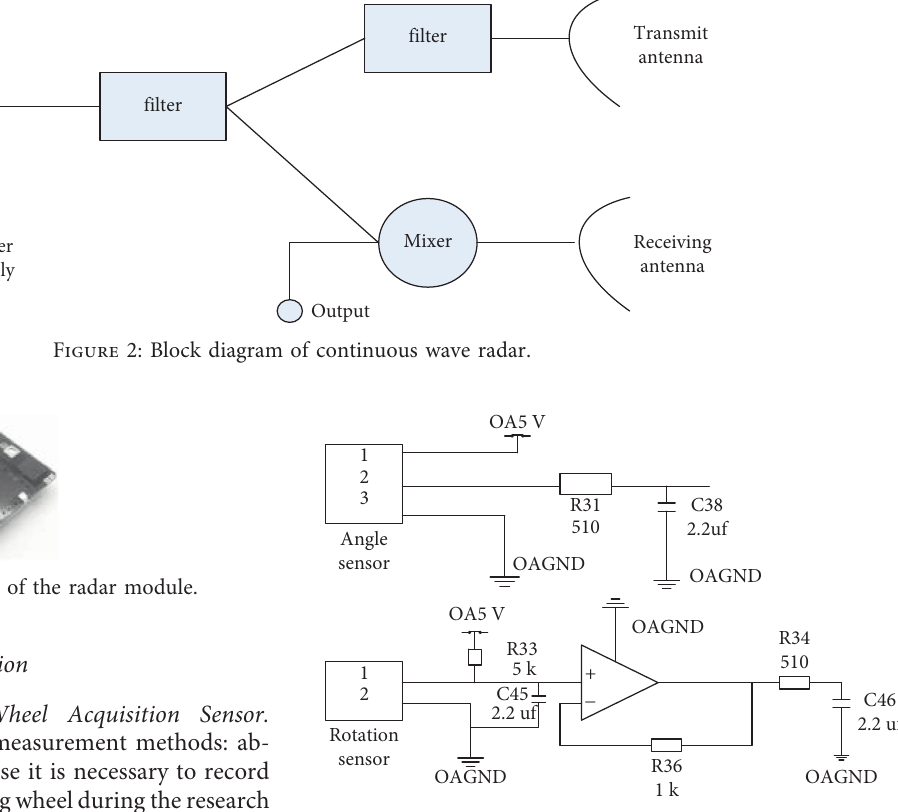
Figure 4: Schematic diagram of angle sensor.